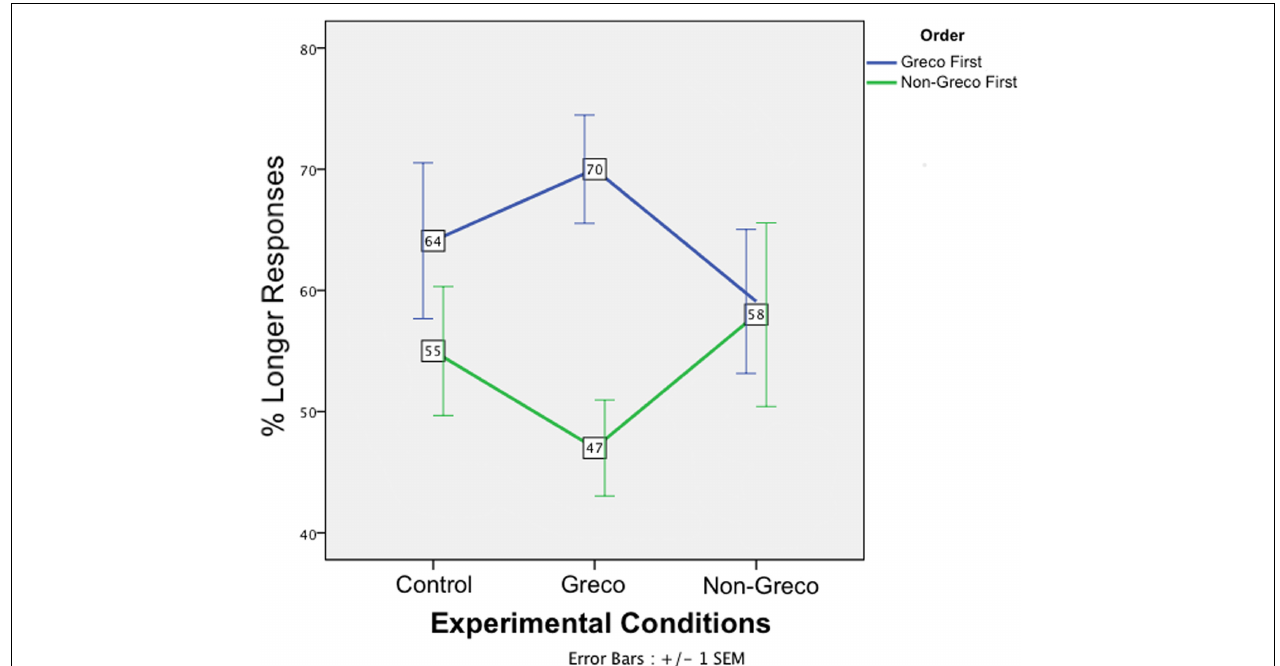
FIGURE 2 | Effects of the posthypnotic suggestion on time judgments. The graph shows the mean percentage of Longer responses according to Experimental Conditions (Control, Greco and Non-Greco types of trials) and participants presented with the Greco Block first (blue) and participants presented with the Non-Greco Block first (green). Error bars indicate 1 ±